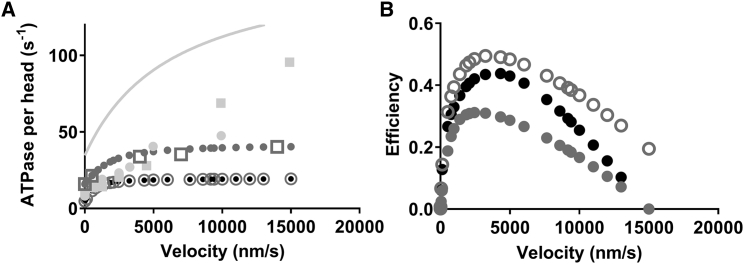
Steady-state ATP turnover rate and thermodynamic efficiency. (A) ATP turnover rate per all available (not only attached) myosin heads as a function of sliding velocity on the assumption of linear (black) or nonlinear (dark gray) cross-bridge elasticity. The nonlinear cross-bridge elasticity was simulated either assuming that the elasticity is nonlinear for all attached states (filled dark gray circles) or only for the AM/AMD state (open gray circles). Experimental data are illustrated by the light gray line and symbols from (69) (circles), (102) (line), and (70) (squares). The velocity data were transformed from the original experimental values by first normalizing velocity to the unloaded velocity in each experiment and then scaling to the high-temperature value of our simulations. The ATP turnover rate was transformed by assuming Q10 = 2.9 for ATP turnover rate at all velocities. For more details, see text. All simulated data represented by circles were obtained without consideration of periodic boundary conditions. Control simulations using periodic boundary conditions are represented by open squares for nonlinear cross-bridge elasticity. (B) Thermodynamic efficiency data calculated from simulated results in Figs. 6B and 9A. The same grayscale coding as in (A) is used.